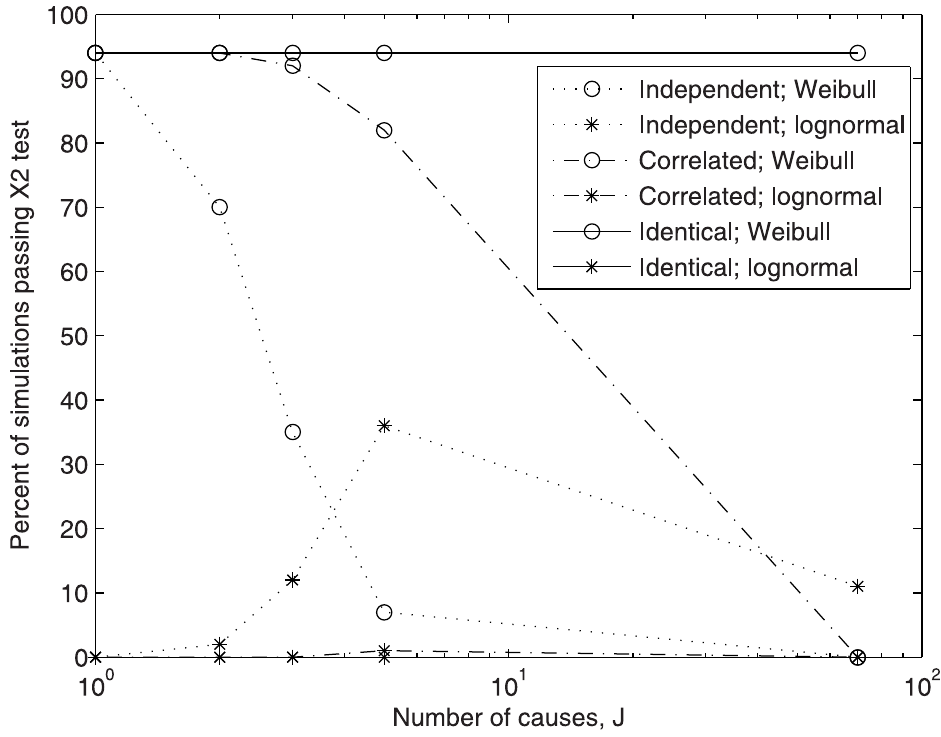
Fig 2. The number of simulated distributions passing a chi squared test for fit to the Weibull and lognormal distributions, as a function of the number of multiplicative asymptotic exponential causes and causal dependence. [Conditions: 1000 sets of N = 1000 simulated data points, α =